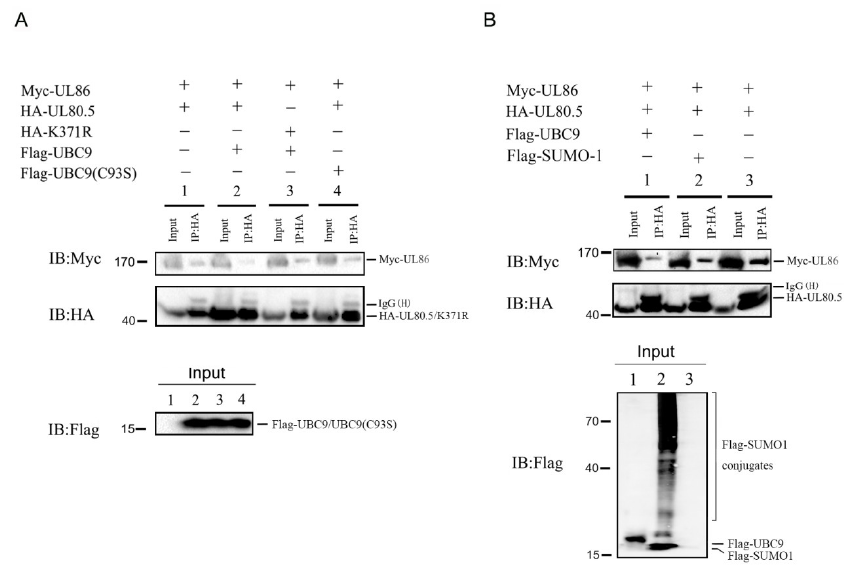
Figure 4. SUMOylation of UL80.5 restrains its interaction with UL86. ( A ) HEK293T cells were trans- fected with Myc-UL86, HA-UL80.5, or HA-K371R with or without Flag-UBC9 or Flag-UBC9(C93S). Cell lysates were subjected to Co-IP with HA antibody followed by immunoblot analysis. Data are representative of four independent experiments. ( B ) HEK293T cells were transfected with Myc- UL86 and HA-UL80.5 with or without Flag-UBC9 or Flag-SUMO1. Cell lysates were subjected to Co-IP with HA antibody, followed by immunoblot analysis. Data are representative of three inde- pendent experiments.